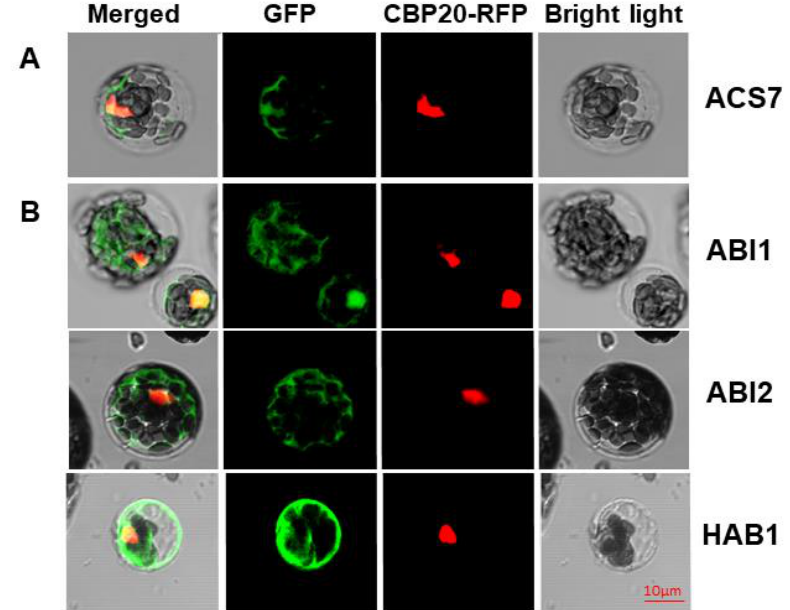
Figure 1. In planta localization study. Localization of ACS7–GFP ( A ) and type 2C phosphatases ( B ) in Arabidopsis thaliana protoplasts, by confocal microscopy. CBP20–RFP was used as nuclear marker. Green fluorescence (ACS7–GFP, ABI1–GFP, ABI2–GFP and HAB1–GFP) and red fluorescence (RFP– CBP20) are merged in the left-hand column with the bright field image; scale bar, 10 µm.